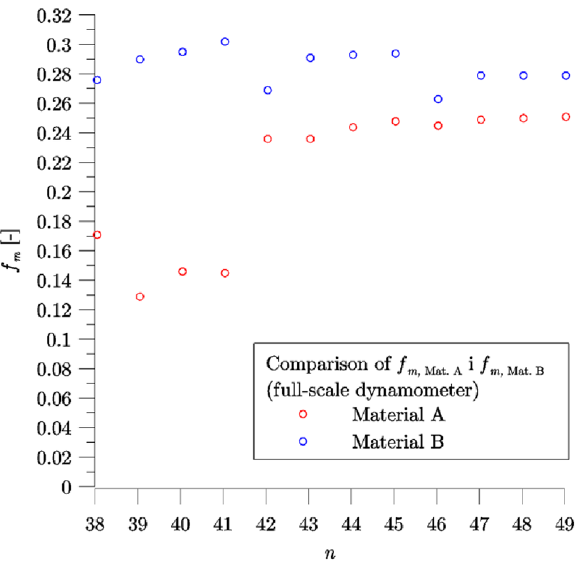
Figure 6. Changes of the mean coefficient of friction during the test process on a full-scale inertia dynamometer with the A and B materials of brake blocks.